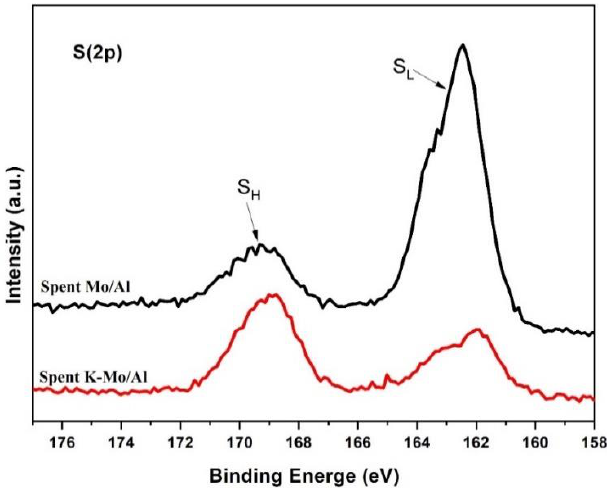
Figure 10. The S(2p) XPS spectra of the spent catalysts.